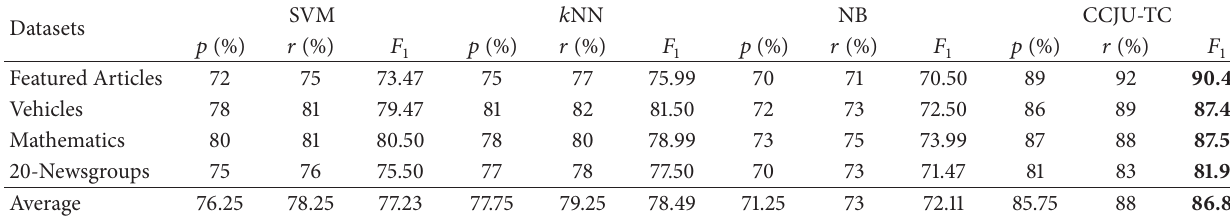
Figure 4: Text classification process based on cloud concept jumping up. Table 2: Classification performance of different classifier with IG.